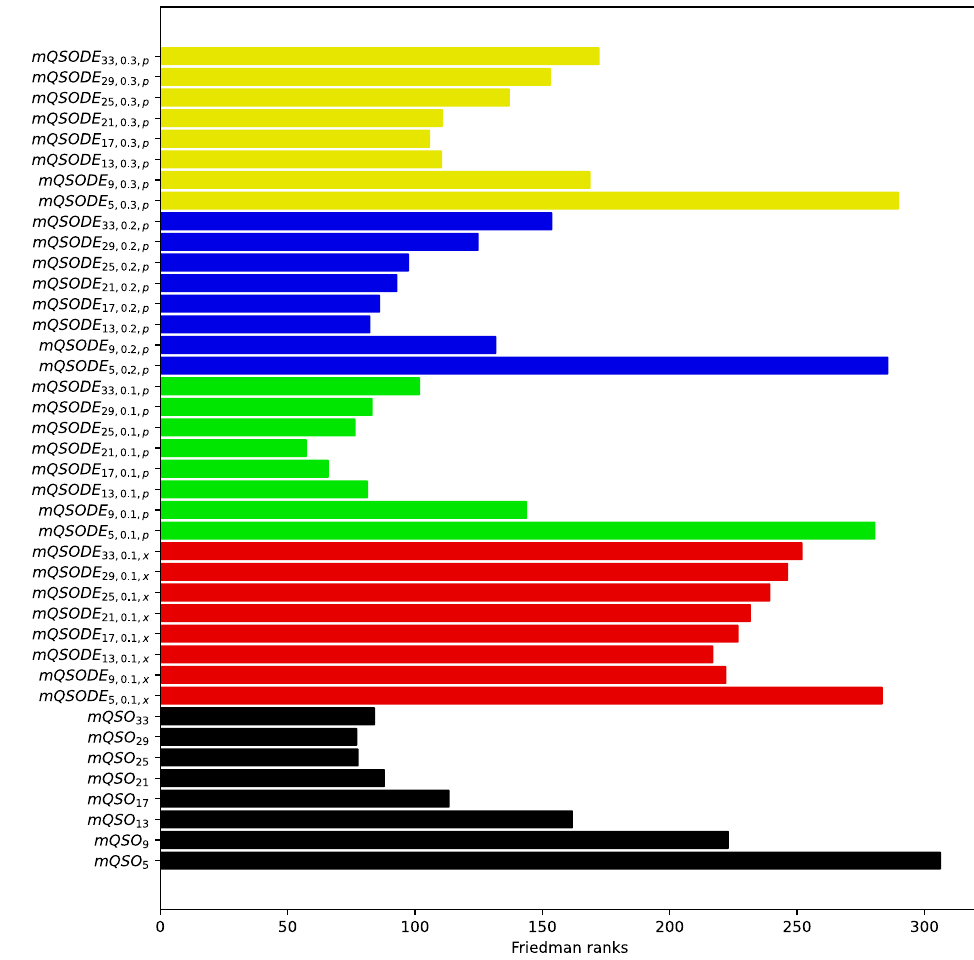
Figure 5. Bar plot Friedman ranks of tested algorithms, aggregated over four settings.